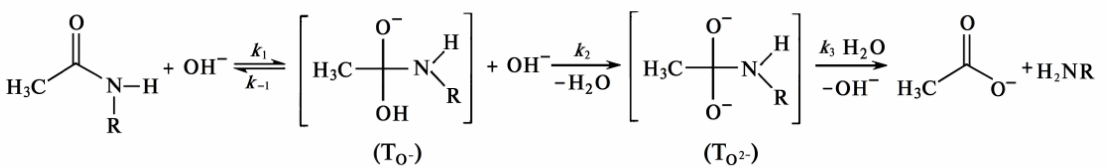
Figure 14. Scheme of the mechanism of cleavage of the acetamide bond in a concentrated alkali solution.